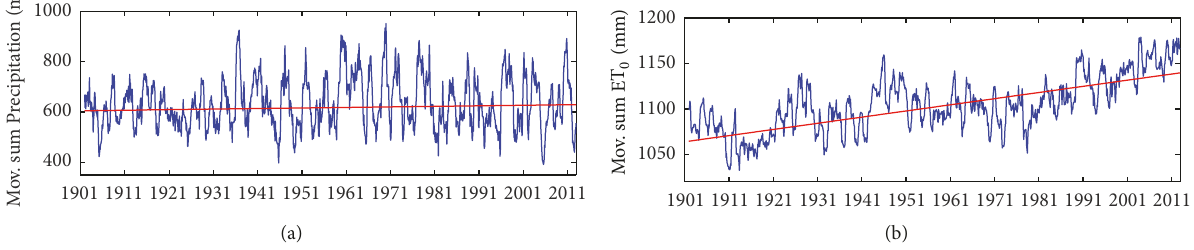
Figure 1: Moving sum of the spatial averaged precipitation (a) and reference evapotranspiration (ET 0 ) (b) determined by the Hargreaves method over the IP during the period 1901–2012, and the corresponding linear trend (red bold line).